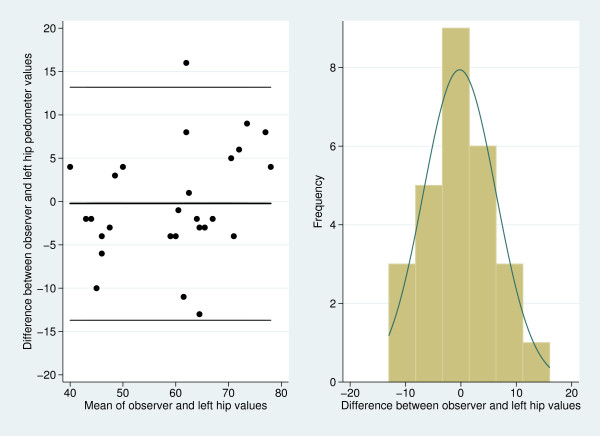
Scatter-plots of measurement differences against measurement averages with
the 95% limits of agreement superimposed and histogram of measurement
differences for comparisons of step counts between the observer and the left
hip placed pedometer. The 95% limits of agreement appear as the outer
lines in the left hand figure while the mean estimate of bias is given by the
intermediate line.